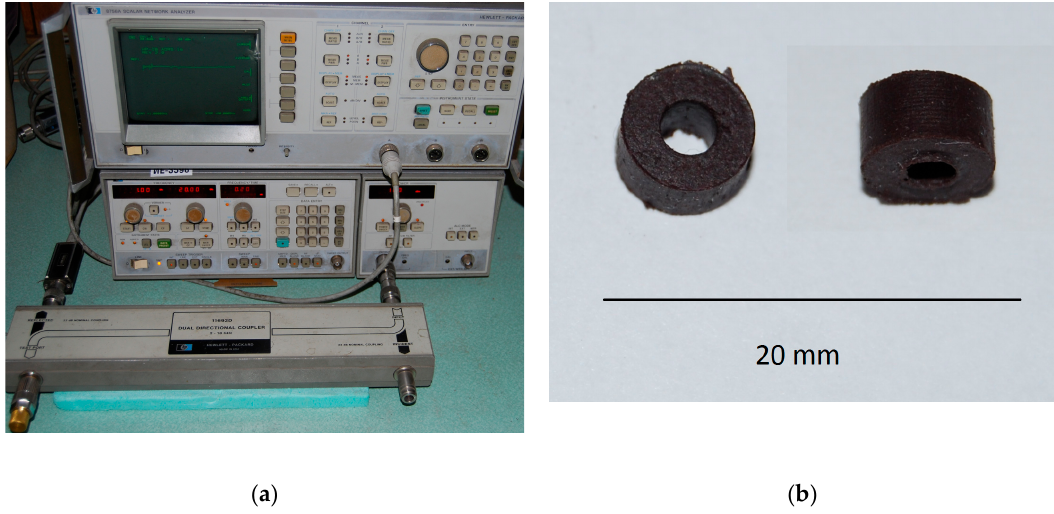
Figure 9. Photographs of the experimental setup ( a ) and of a toroidal sample-two points of view ( b ).